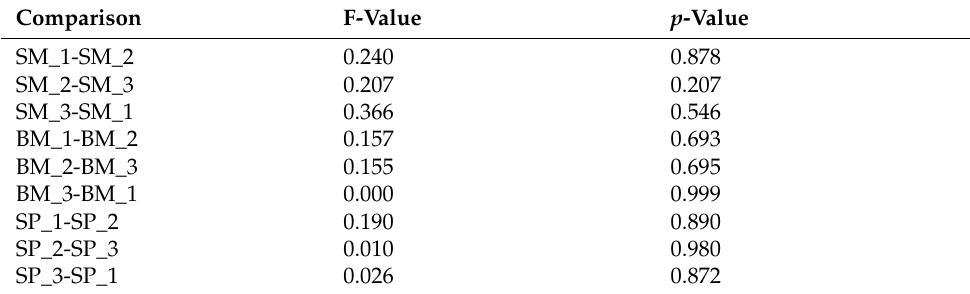
Table 6. Parametric ( t -test) comparison of the datasets into groups.